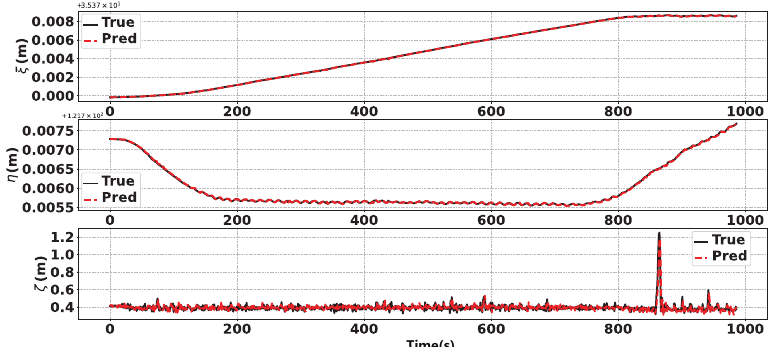
Figure 16. Identification result of AUV